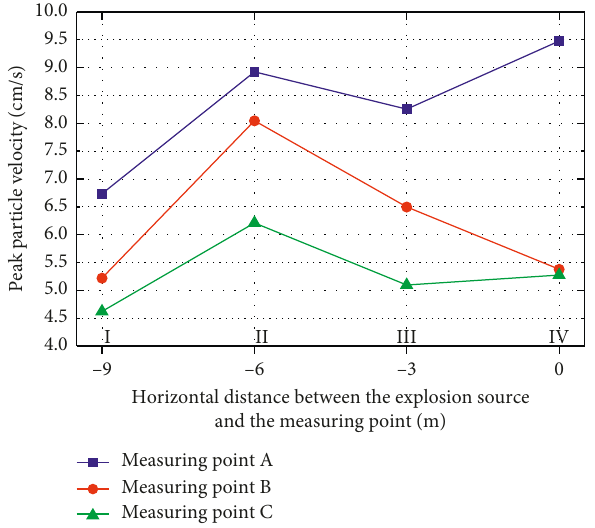
Figure 7: Trends of PPV at Points A, B, and